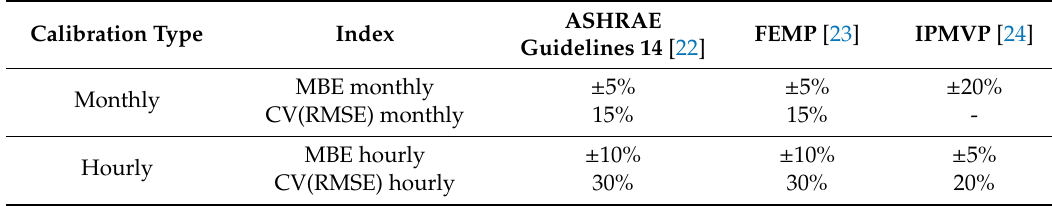
Table 2. Acceptable calibration